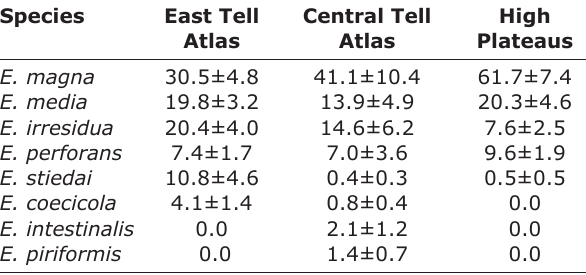
Table-3: Prevalence of Eimeria species in three regions of Algeria.